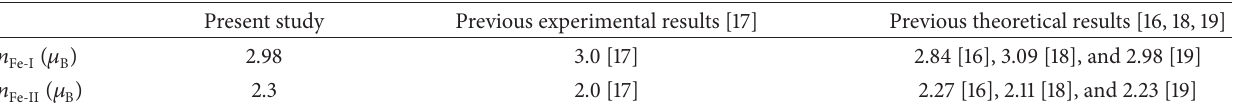
Table 3: A comparison in magnetic moments of 𝛾 󸀠 -Fe 4 N between present numerical and previous experimental or theoretical data [16–19], at 𝑎 = 3.772 ˚A.